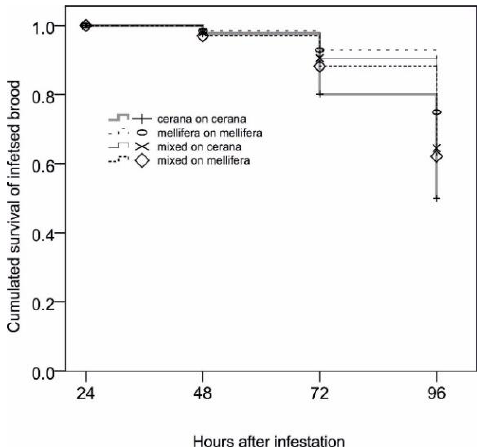
Figure 4. Survival of T. mercedesae -infested Apis cerana and A. mellifera brood in the presence of workers of both species.